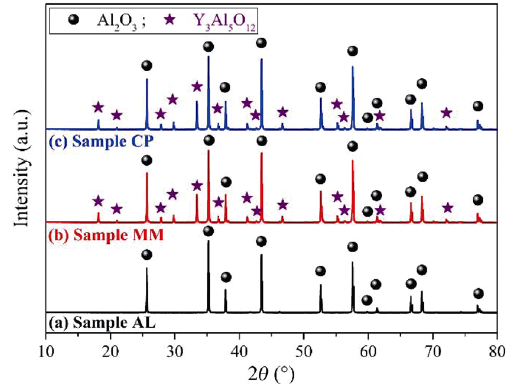
Fig. 8 XRD patterns for the prepared Al 2 O 3 ceramic samples.